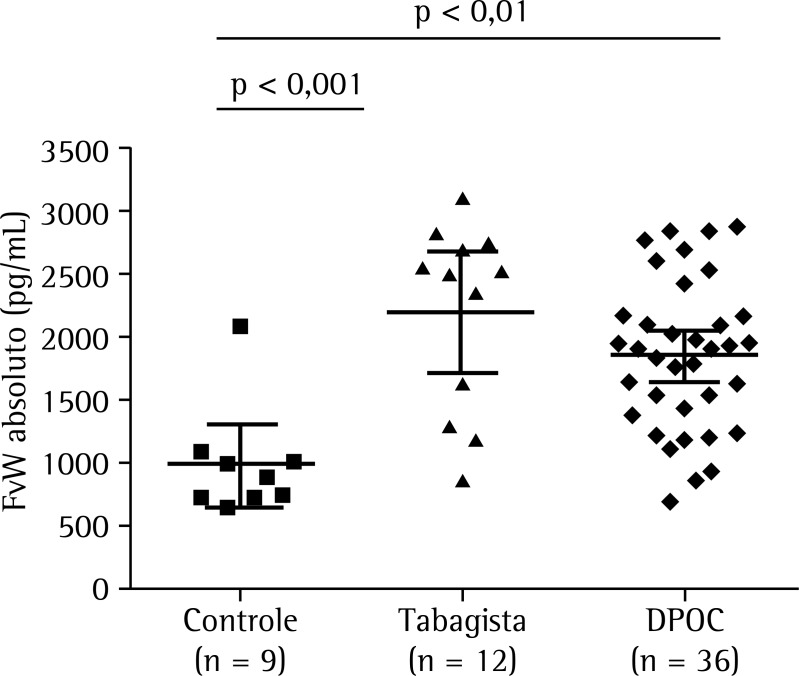
Níveis séricos absolutos do fator de Von Willebrand (FvW) nos grupos
estudados.